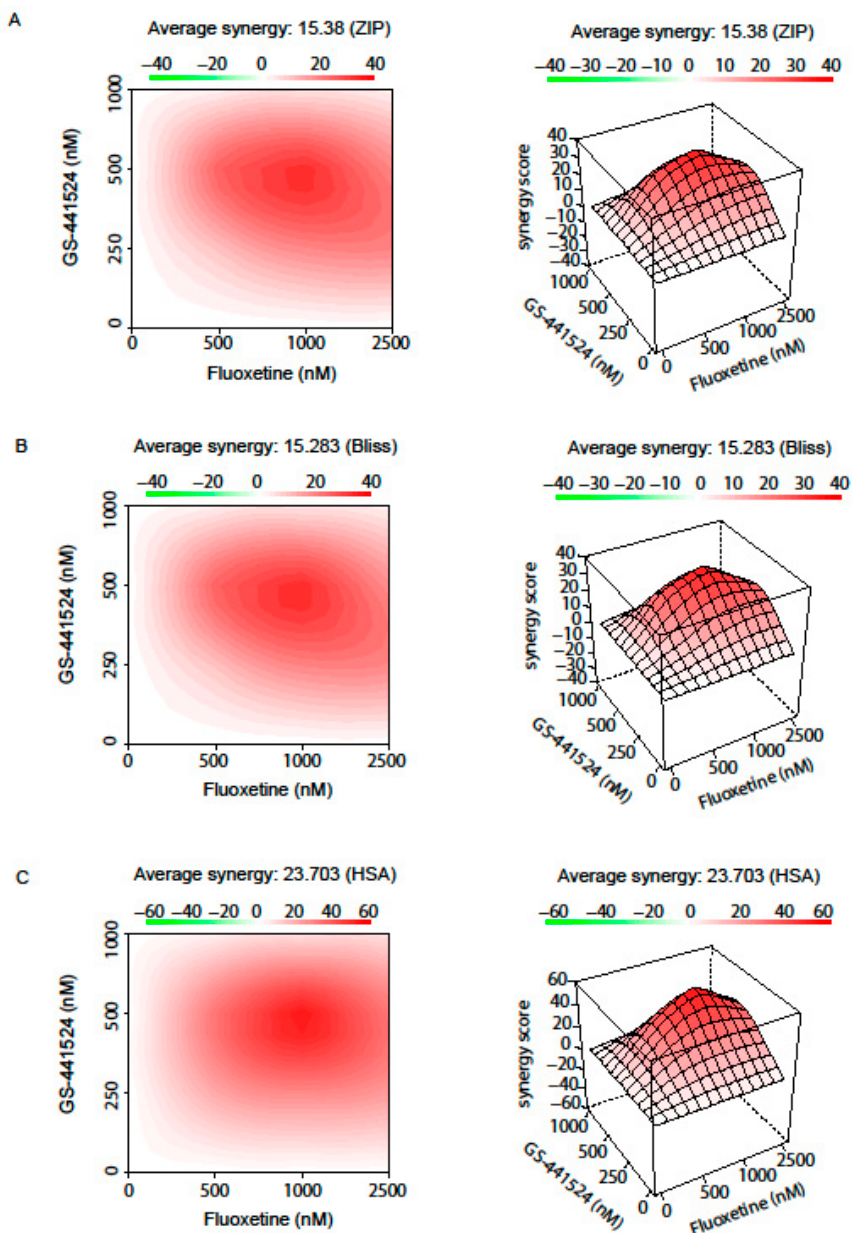
Figure 4. Pharmacological interaction profile of the drug pair GS-441524 and fluoxetine. Drug interactions were analyzed based on the three commonly used reference models: ( A ) Zero Interaction Potency (ZIP), ( B ) Bliss independence, and ( C ) highest single agent (HSA). While the HSA model assumes a synergistic drug combination that produce additional benefits on top of what the drugs can achieve alone, the Bliss independence model uses probabilistic theory to model the effects of individual drugs in a combination as independent yet competing events. Synergy calculations via the ZIP model includes the comparison of potency changes of the dose–response curves between individual drugs and their combinations. A color-coded interaction surface was used to illustrate the synergy scores of the responses, where high synergistic scores are colored in red. Synergy score calculations via the ZIP and Bliss independence model revealed a synergy of ~ 15, while the HSA model showed a higher synergy score of